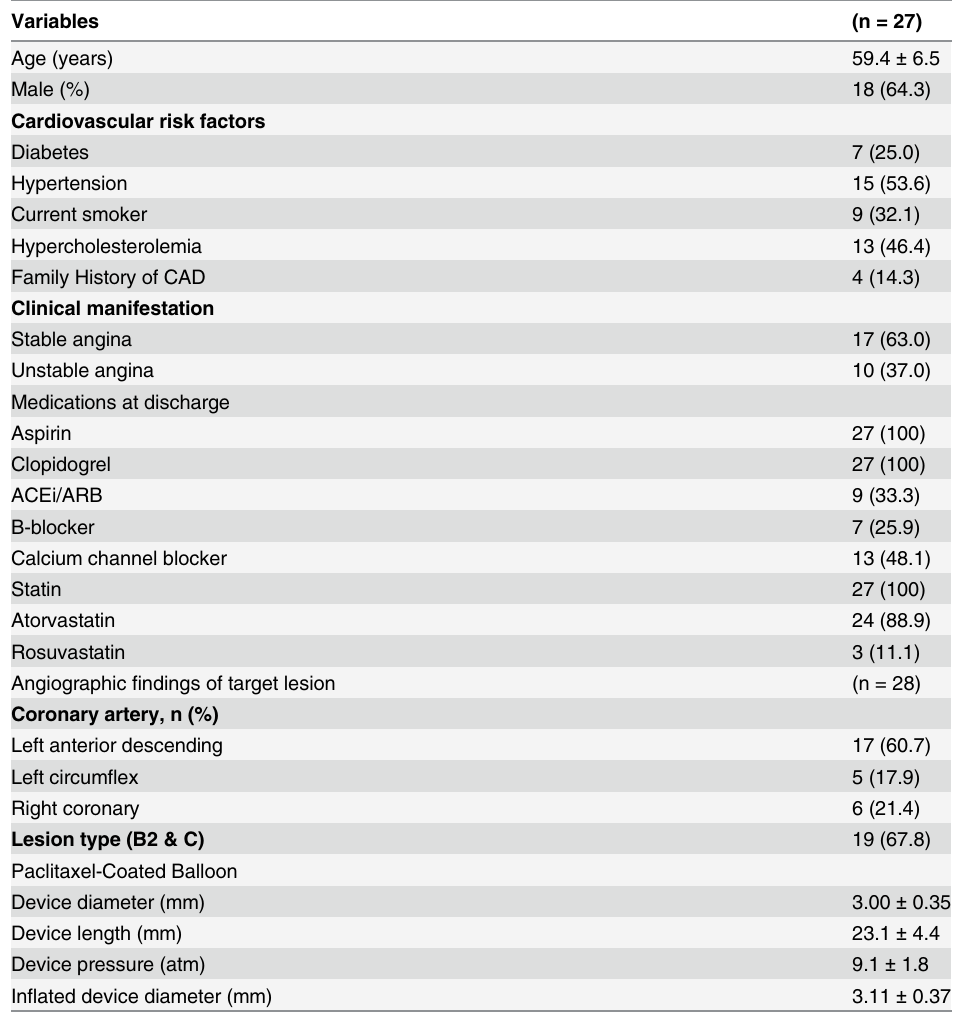
Table 1. Baseline and procedural